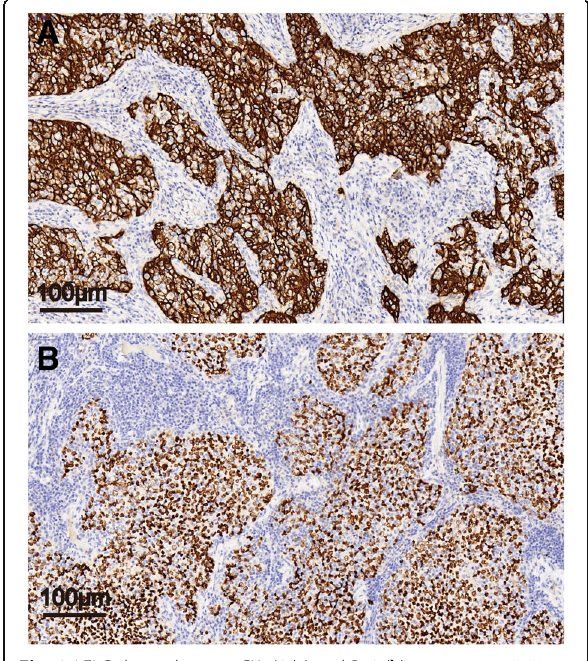
Fig. 2 LELC showed strong CK5/6 ( a ) and P40 ( b ) immunoreactivities